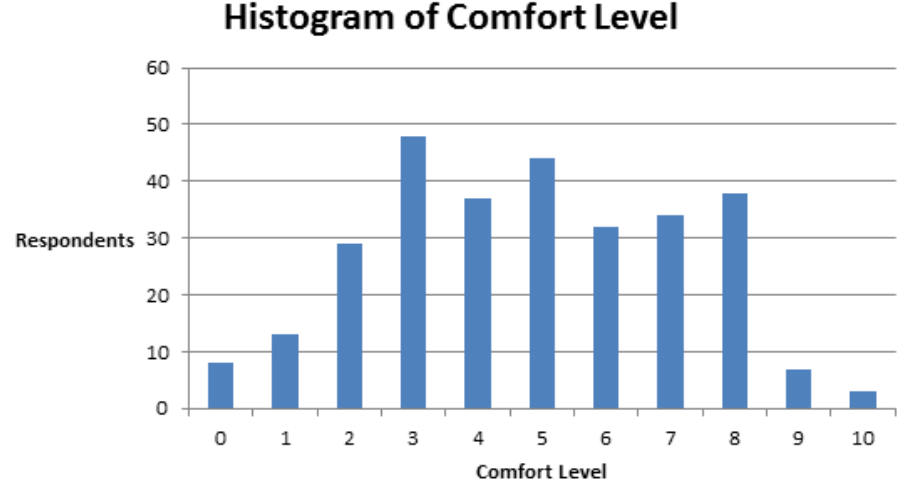
Figure 1 . Histogram of EM residents’ reported comfort with performing a cricothyrotomy unassisted by another practitioner upon graduation; “10” represents complete confidence.